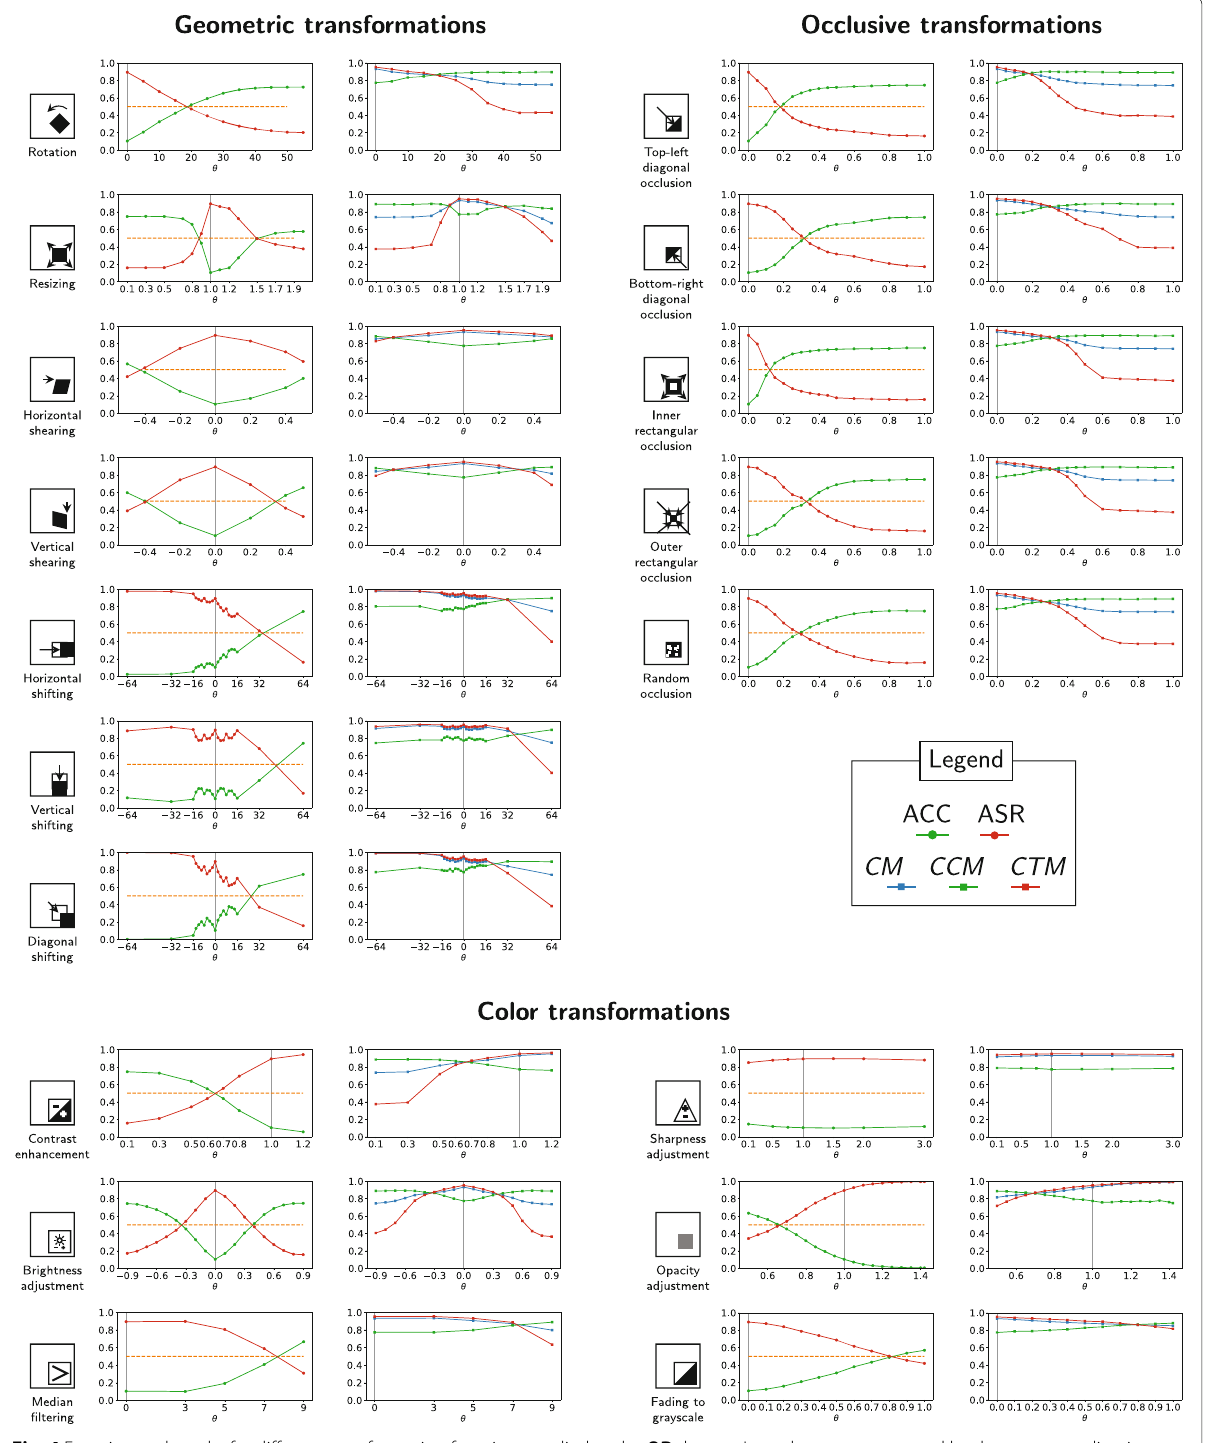
Fig. 4 Experimental results for different transformation functions applied to the OR dataset. In each case, represented by the corresponding icon, we plot the performance metrics as functions of the transformation parameter θ . The left plots report ACC and ASR (in green and red, respectively), and the right plots reports the average confidence values CM , CCM , and CTM (in blue, green, and red, respectively). The baseline case where φ θ ( · ) is the identity function is indicated with a vertical gray line. The horizontal orange line marks the level of ACC and ASR equal to